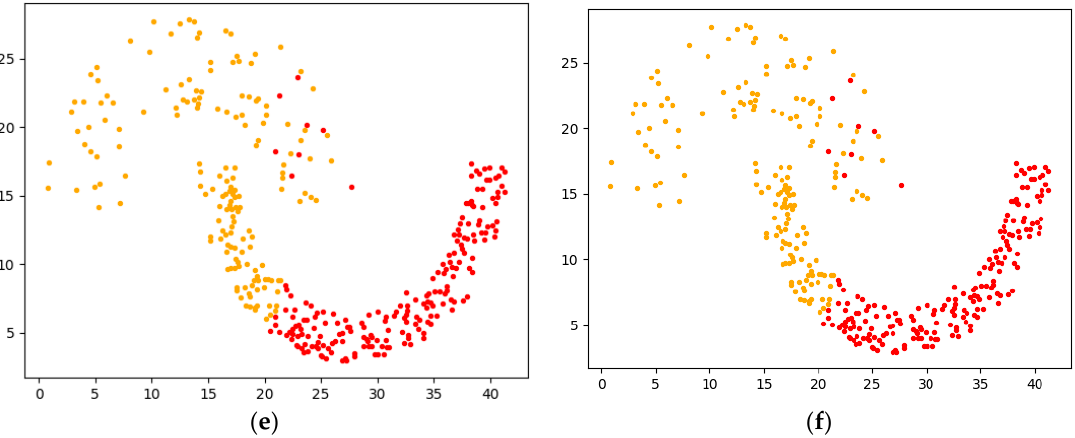
Figure 10. Visual analysis of Jain dataset [17,18]. ( a ) Original. ( b ) F-DPC. ( c ) DPC. ( d ) Reference [17]. ( e ) Reference [18]. ( f ) K-means. Experiment 2 uses the Unbalance dataset with a large number of samples for com- parison, in which the Unbalance dataset has 6500 samples and eight cluster centers. The visualization results of each algorithm clustering are shown in Figure 11.